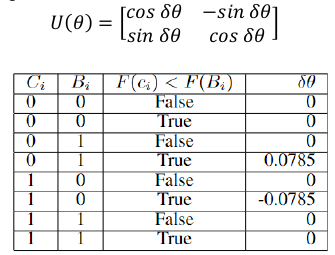
Table 1: Look-up table for rotational